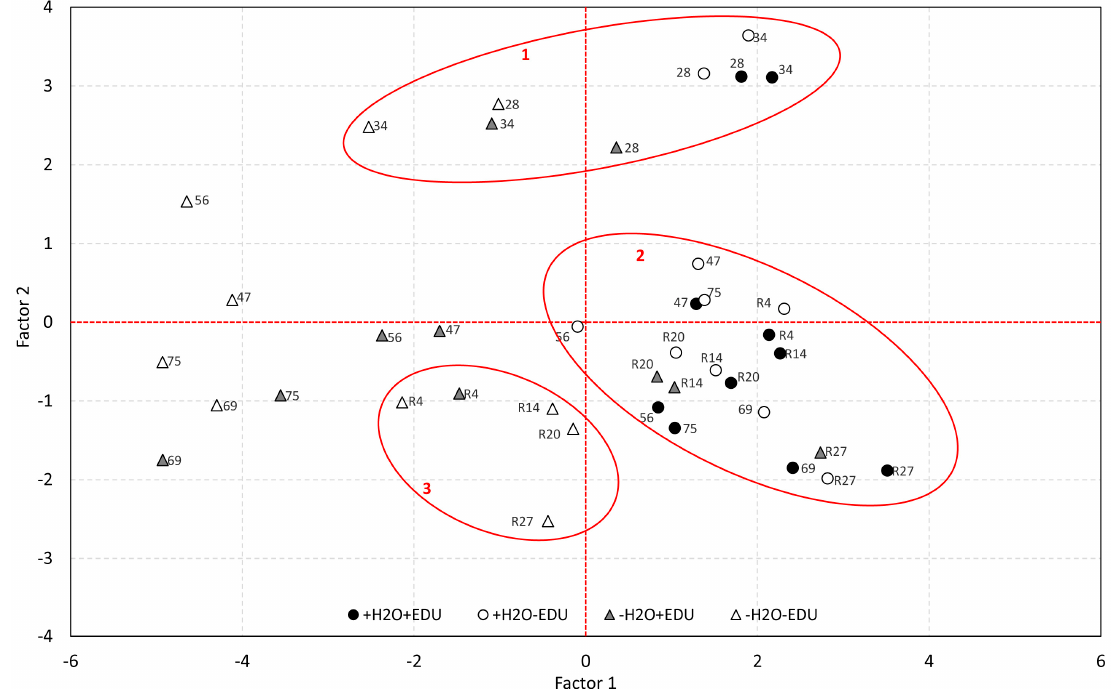
Figure 5. Principal Component Analysis obtained by pooling together the ecophysiological data, soil water content, AOT40 and maximum daily ozone concentrations, measured from DOT 28, after the beginning of both water stress and EDU treatments, to R27. For each point, the Day of Treatment is reported. Cluster borders and numbers are marked in red (See text for further details).